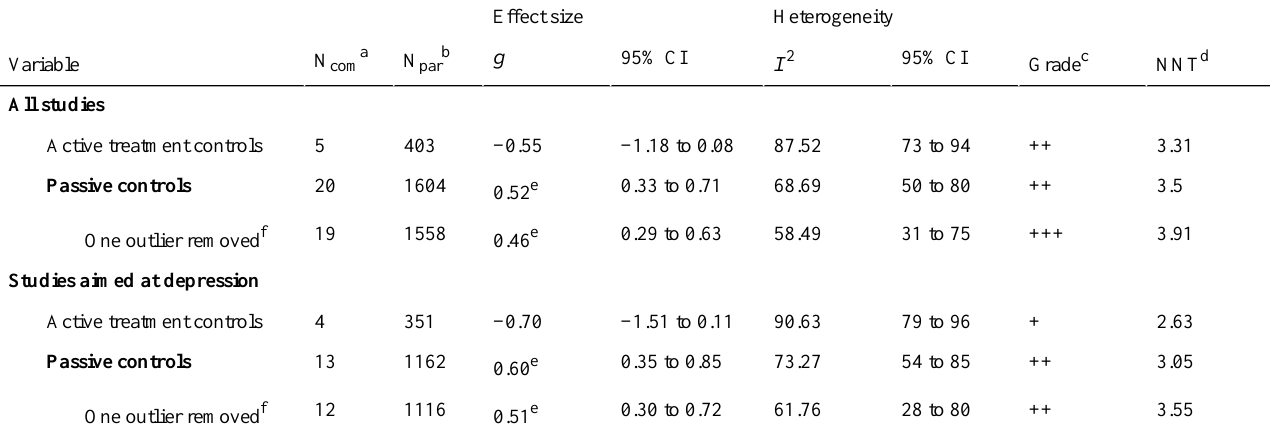
Table 1. Effect sizes regarding depressive symptoms in the meta-analysis of studies comparing computerized cognitive behavior therapy in adolescents and young adults with active treatment and passive controls at